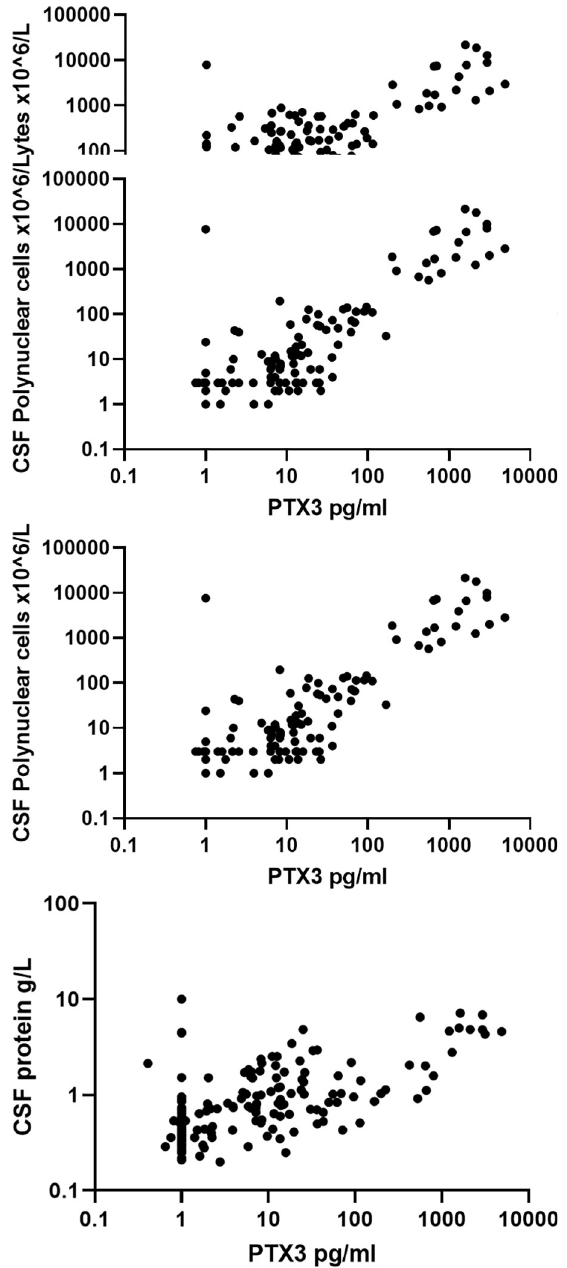
Fig 3. PTX3 correlation to CSF cell count, CSF polynuclear cell count and CSF protein concentration.